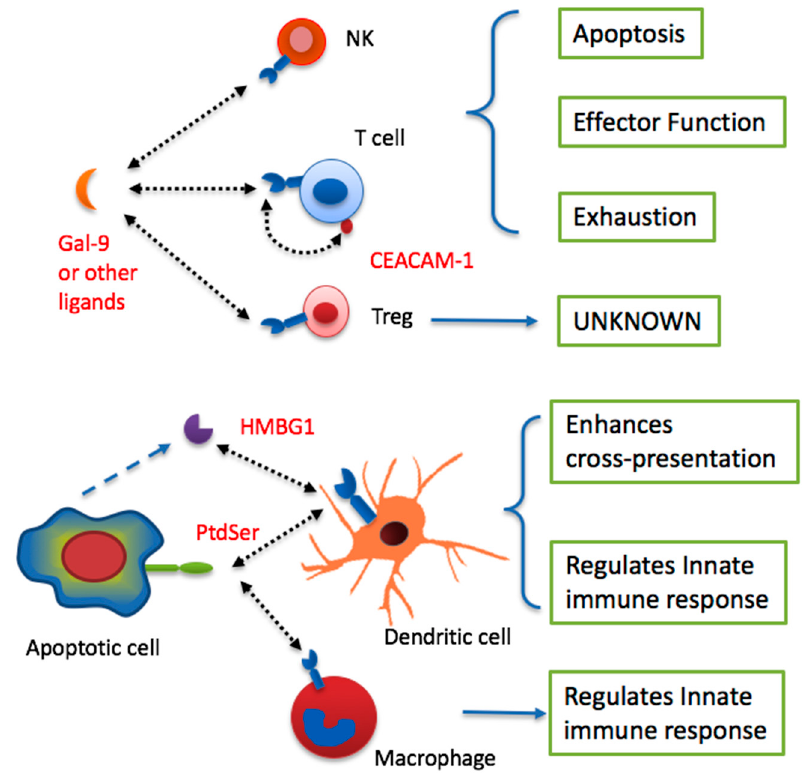
Figure 2. Summary of multiple biological functions of TIM-3 on various immune cells. TIM-3 signaling in T cells and NK cells leads to the development of effector functions, apoptosis, or exhaustion. The effect on Tregs remains unknown. Likely dependent on the cellular context, TIM-3 signaling can enhance cross-presentation of dendritic cells (DC) or inhibit innate immune responses of DC and macrophages.